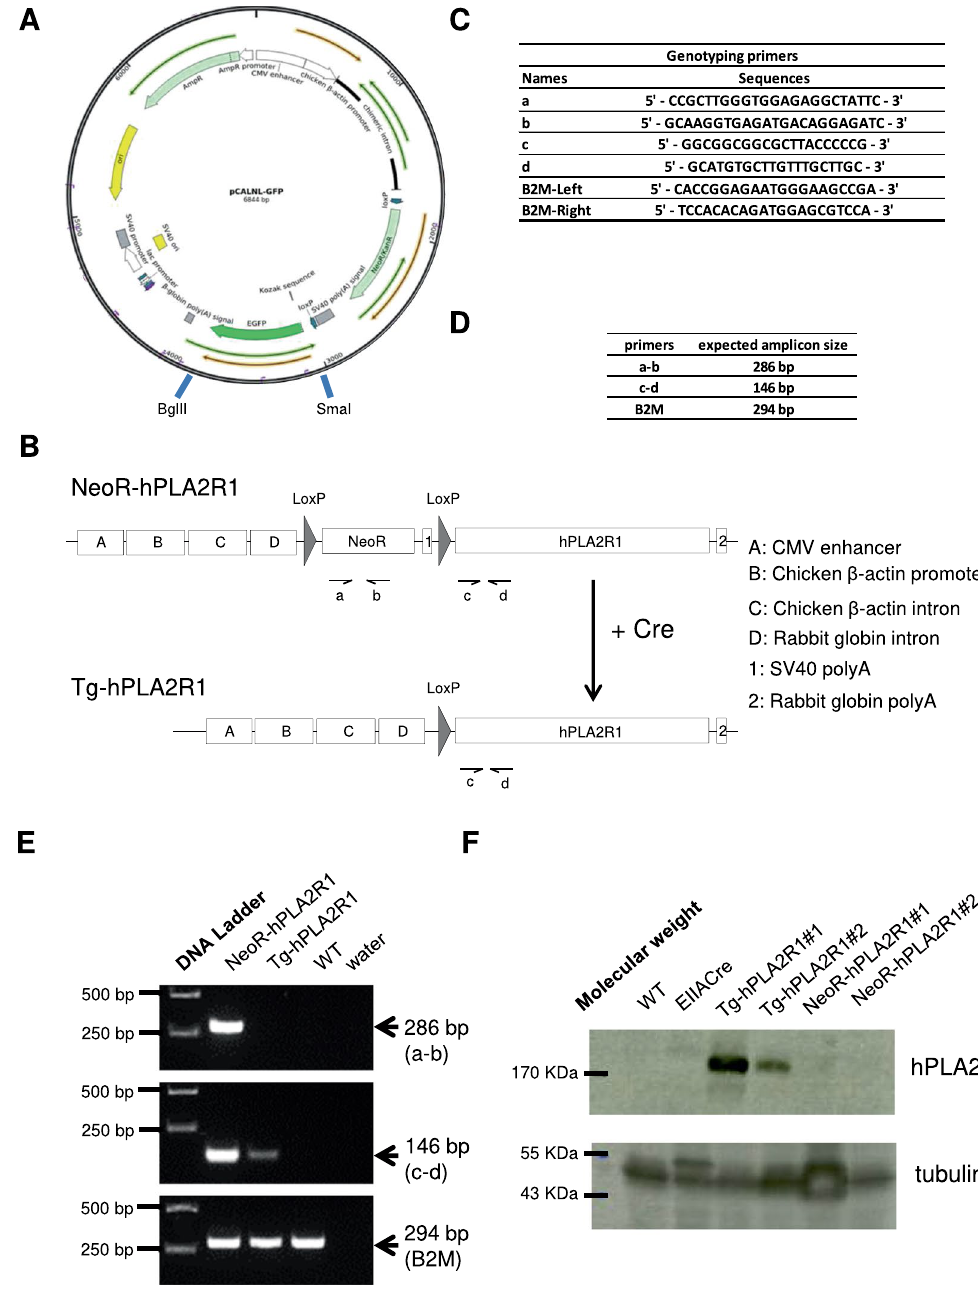
Figure 1. Strategy to generate NeoR-hPLA2R1 and Tg-hPLA2R1 mice. ( A ) Map of pCALNL-GFP backbone vector used for transgenesis. The pCALNL/hPLA2R1 vector was generated by replacing the GFP coding sequence by that of hPLA2R1. ( B ) Schematic representation of NeoR-hPLA2R1 and Tg-hPLA2R1 transgenic constructs prior to and after Cre excision of the LoxP-NeoRStop-LoxP sequence. Arrows show the position of genotyping primers. ( C ) Sequences of the primers used for genotyping NeoR-hPLA2R1 and Tg-hPLA2R1 transgenic mice. Beta-2-microglobulin (B2M) was used as an internal gDNA control. ( D ) Expected size of the respective amplicons obtained after PCR amplification with indicated primers. ( E ) Representative picture of a genotyping PCR run on an agarose gel and stained with SYBR-safe DNA dye. Amplicon bands and their respective sizes are indicated by arrows. ( F ) Protein lysates prepared from liver of 3-months old mice were analyzed by immunoblot. Tubulin was used as a loading